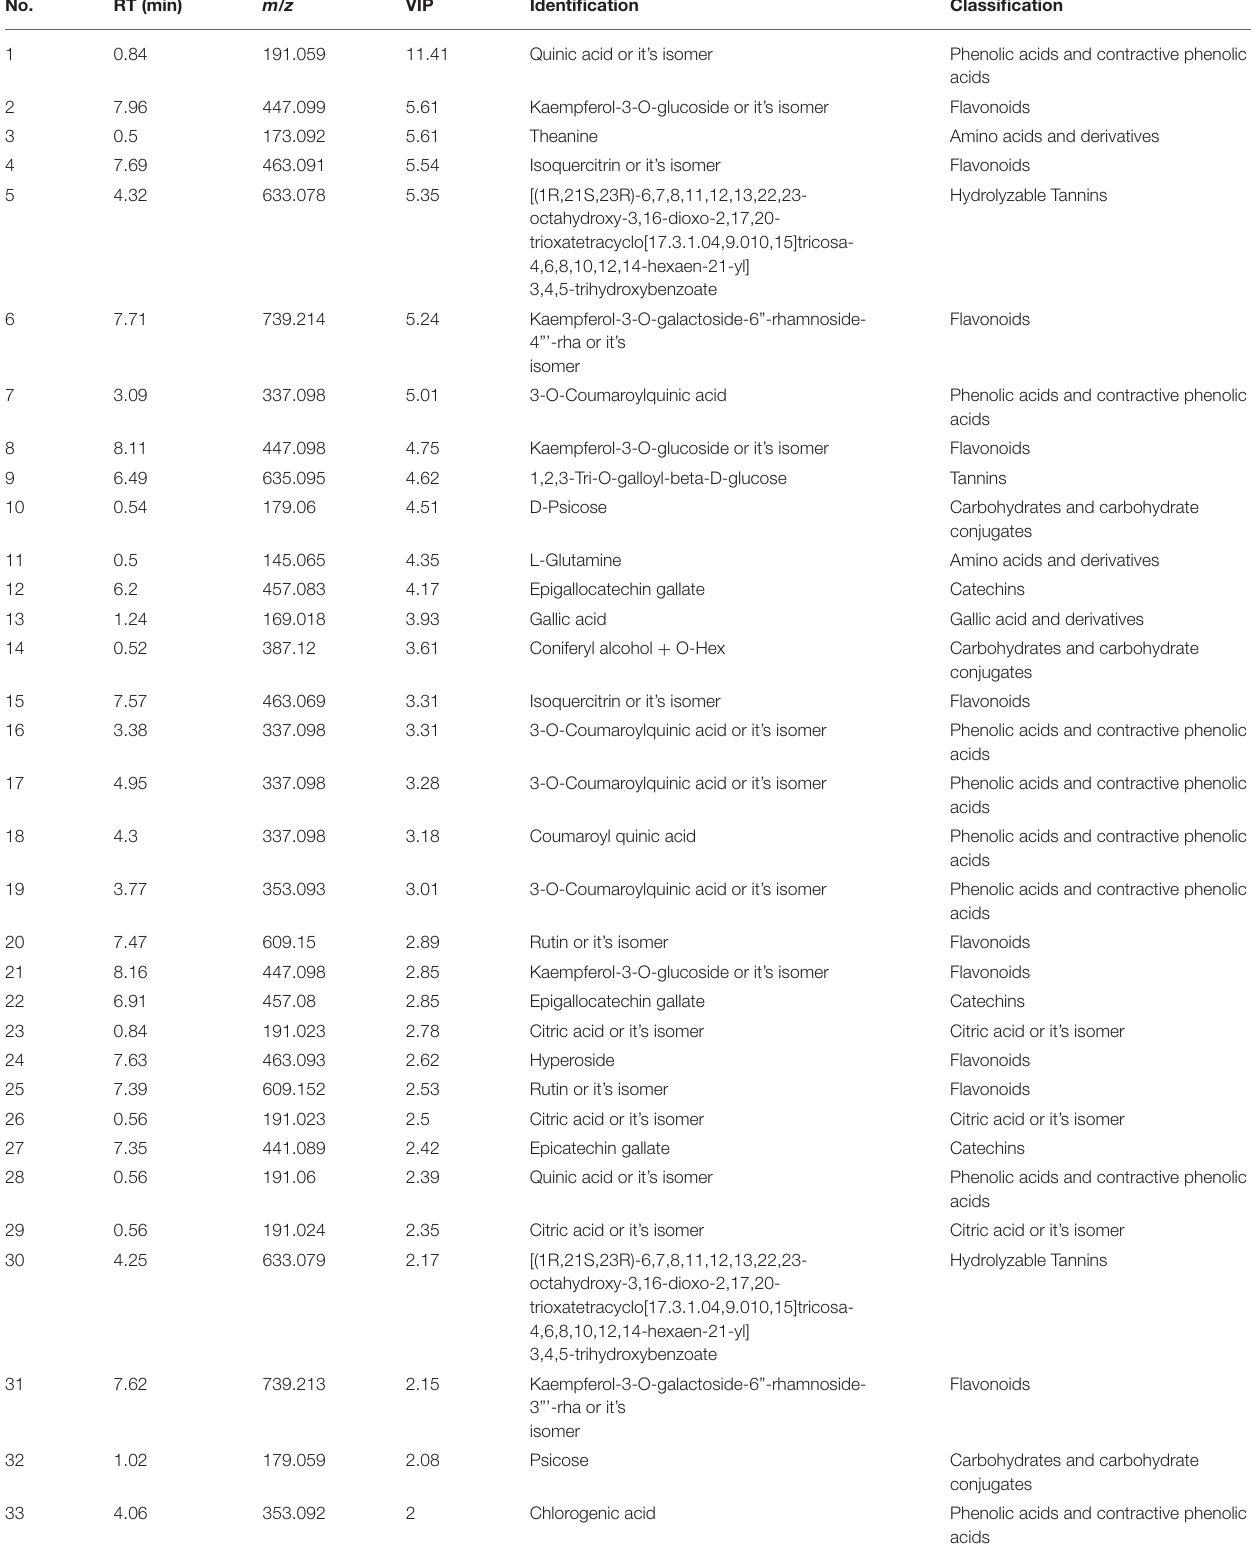
TABLE 1 | Compounds crucial in differentiating Keemun black tea and Dianhong black tea.